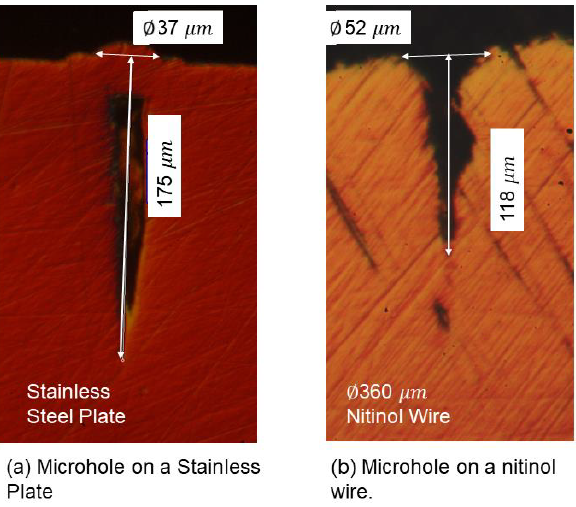
Figure 6: Comparison of microholes drilled by a 10 upmu s pulse on a stainless plate (a) and a nitinol wire (b). Table 1: Material Properties of Stainless Steel and Nitinol